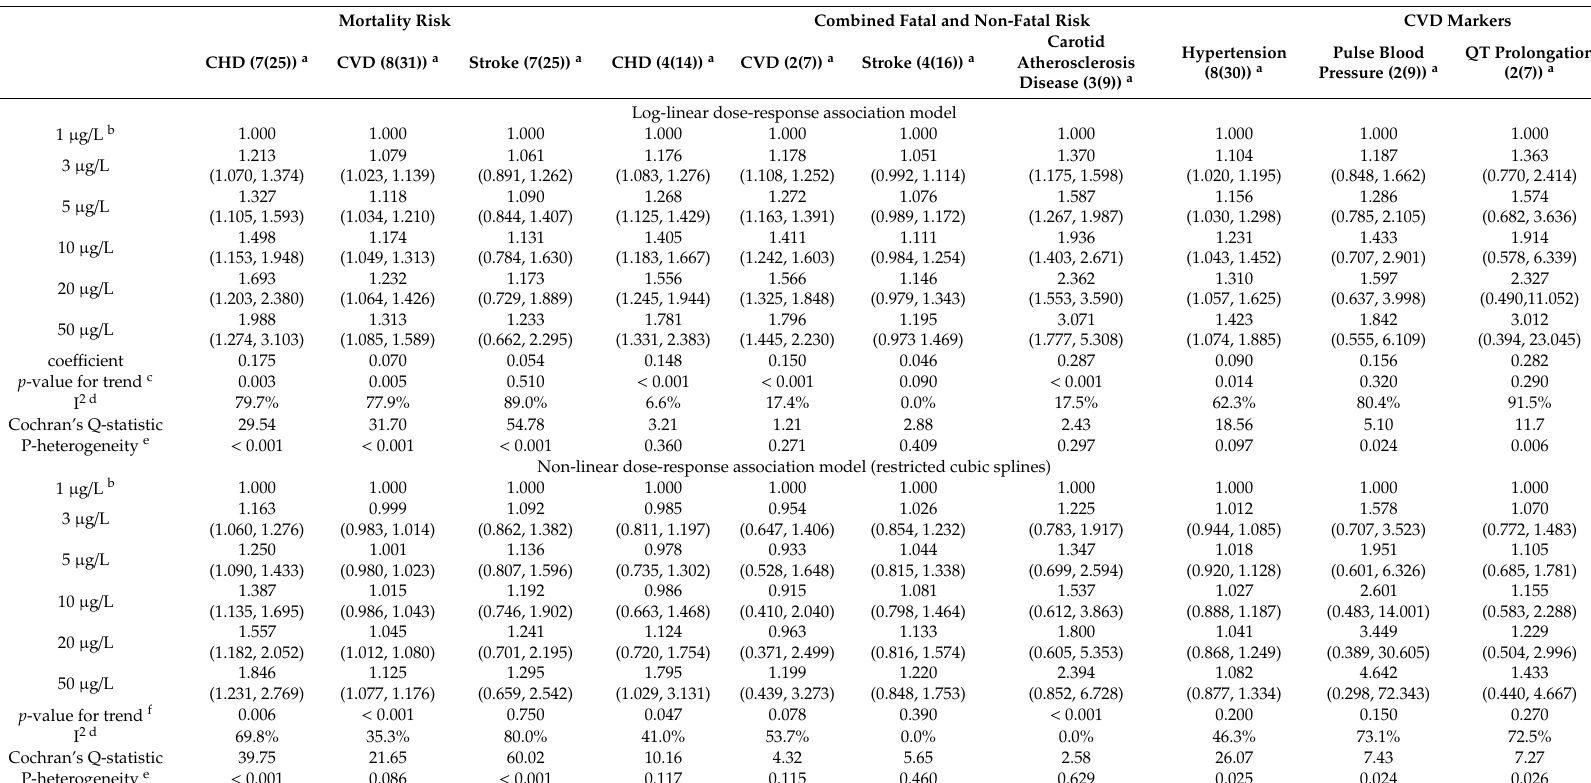
Table 2. Pooled relative risks (95% CIs) for di ff erent types of cardiovascular disease (CVD) and clinic markers in relation to water arsenic concentrations. Mortality Risk Combined Fatal and Non-Fatal Risk CVD Markers Carotid